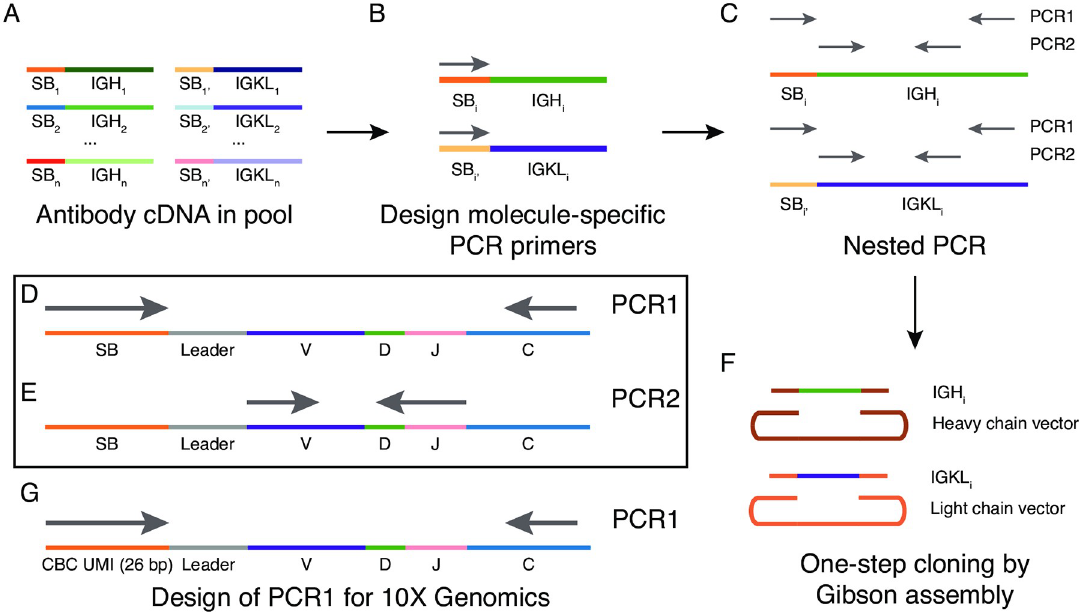
Fig 1. Schematic of workflow for Selective PCR for Antibody Retrieval (SPAR). (A) Antibody heavy- and light-chain cDNA (IGH and IGKL, respectively) from individual cells within a pooled library are distinguished by unique sequence barcodes (SB). For example, the heavy- and light-chain cDNA from cell 1 (IGH 1 and IGKL 1 ) are marked by SB 1 and SB 1’ . (B) Molecule-specific primers are designed to target the sequence barcode. (C-E) Selective amplification of target molecules is performed by two-step nested PCR. Overview of nested PCR design for heavy (top) and light (bottom) chains in shown in (C) and details are shown in (D) and (E). In the first PCR step (PCR1), primers target the unique sequence barcode (SB) and constant region, labeled C. In the second PCR step (PCR2), primers target the 5’ and 3’ ends of the antibody variable region, labeled VDJ. (F) PCR products are cloned into linearized expression vectors by Gibson assembly. (G) Architecture of antibody heavy- or light-chain cDNA after library preparation using 10X Genomics Chromium 5’ V(D)J platform. Sequence barcode consists of 16 bp cell barcode (CBC) and 10 bp unique molecular identifier (UMI). PCR1 forward primer targets this 26 bp sequence. PCR, polymerase chain reaction; cDNA, complementary DNA; IGH, immunoglobulin heavy chain; IGKL, immunoglobulin kappa or lambda chain; SB, sequence barcode; CBC, cell barcode; UMI, unique molecular identifier; V, variable gene; D, diversity gene; J, joining gene; C, constant